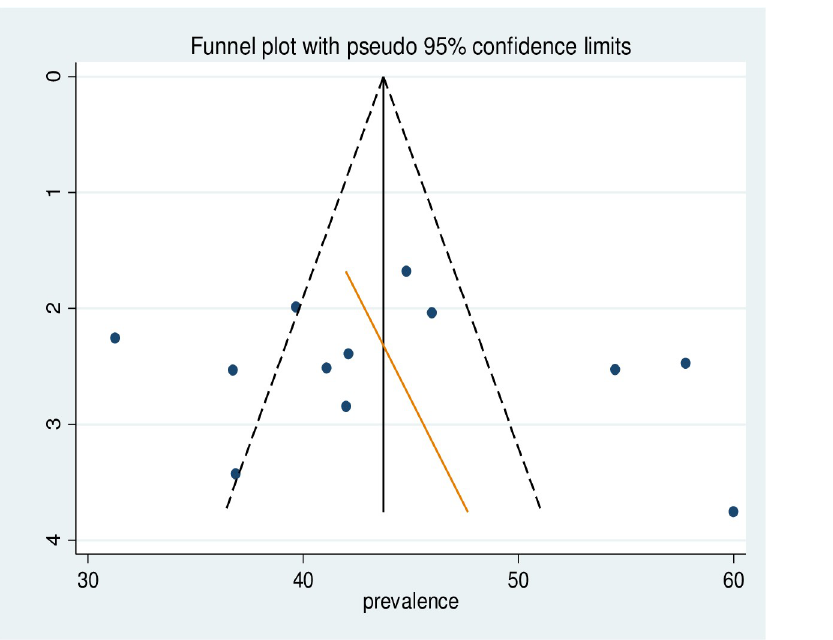
Fig 4. Funnel plot to test publication bias in 14 studies with 95% confidence limit.